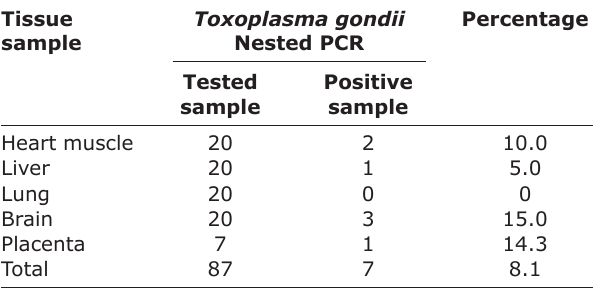
Table-4: Presence of Toxoplasma gondii in different tissue samples from aborted fetus of goats based on nested PCR.